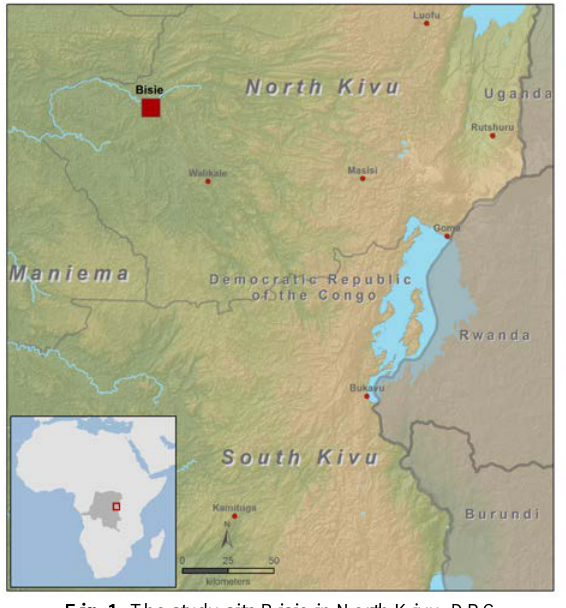
Fig. 1. The study site Bisie in North Kivu,